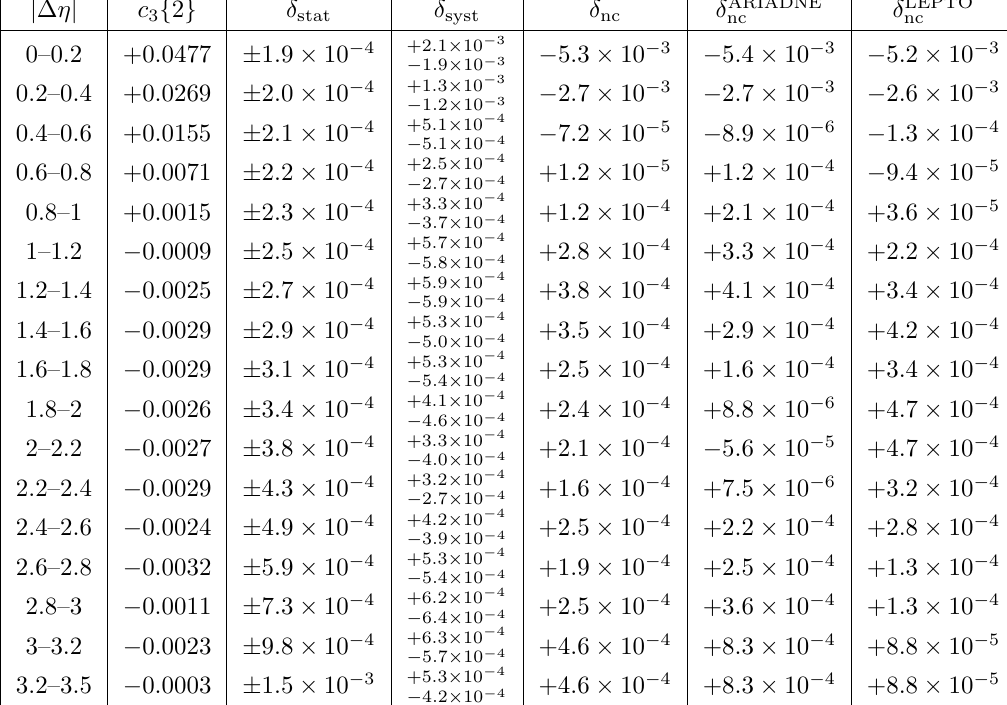
Table 17 . c 3 f 2 g versus j (cid:1) (cid:17) j from (cid:12)gure 8 (c), p T > 0 : 1 GeV; (cid:14) stat , (cid:14) syst and (cid:14) nc denote the statistical, systematic and Monte Carlo non-closure uncertainties,